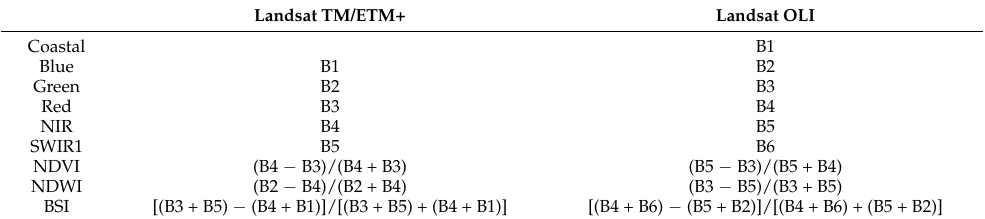
Table 2. Introduction to Landsat bands and spectral indices are used